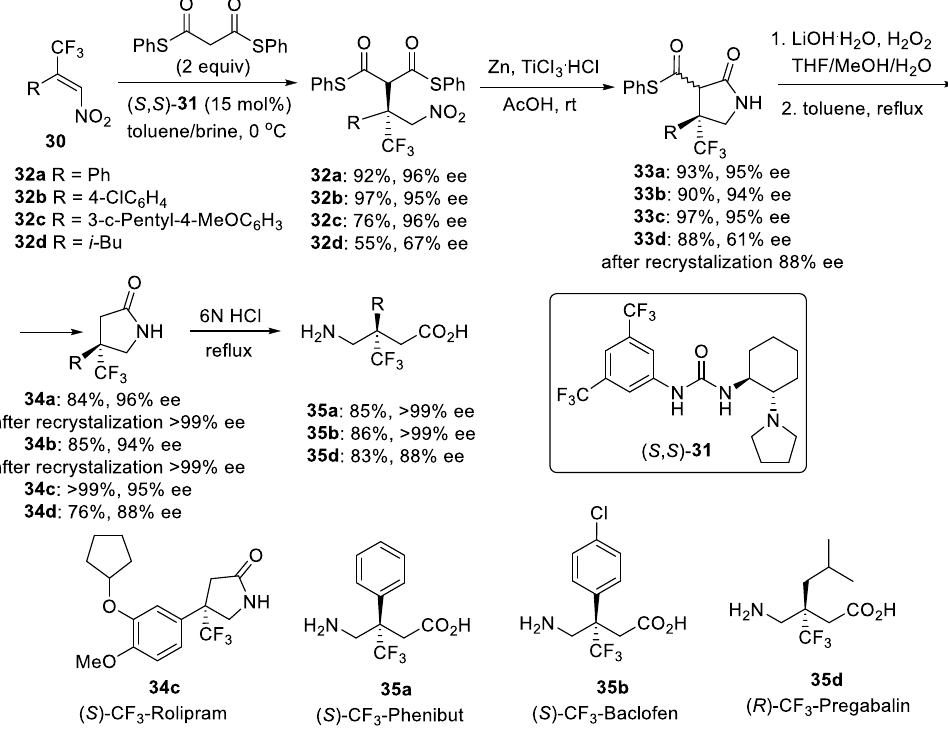
Scheme 7. Synthesis of GABA derivatives with a trifluoromethylated quaternary stereogenic center.